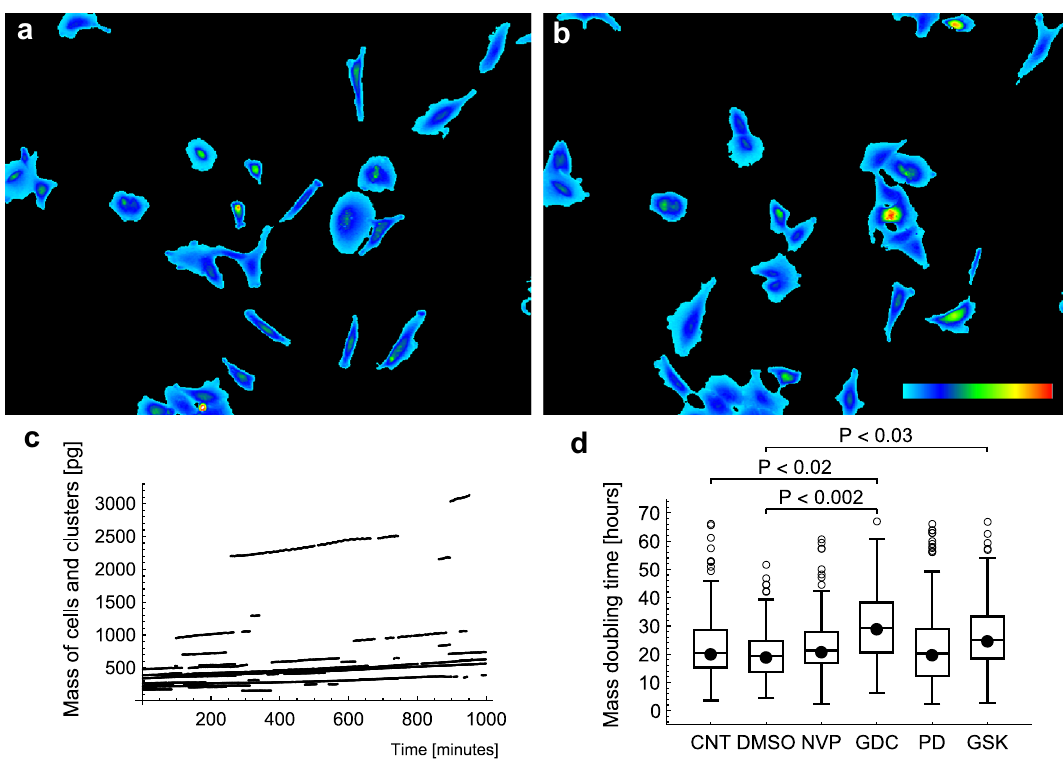
Figure 5. Example images from a time-lapse recording with control A549 cells: ( a ) time point 0 h and ( b ) time point 10 h. The field size is 634 × 483 µm. The pseudo-color bar represents a range of dry-mass densities from 0 to 2.7 pg µm −2 . ( c ) Growth curves illustrate the increase in dry-mass of cells and clusters in the recording. ( d ) Box and whisker plot of the mass doubling time showing a significant reduction in growth—extended doubling time, with GDC in comparison to CNT and DMSO. GSK achieved a smaller reduction, only significant in comparison to DMSO. Dots represent medians, boxes span 50% of the data, whiskers span the full range of data, and outliers are shown as open